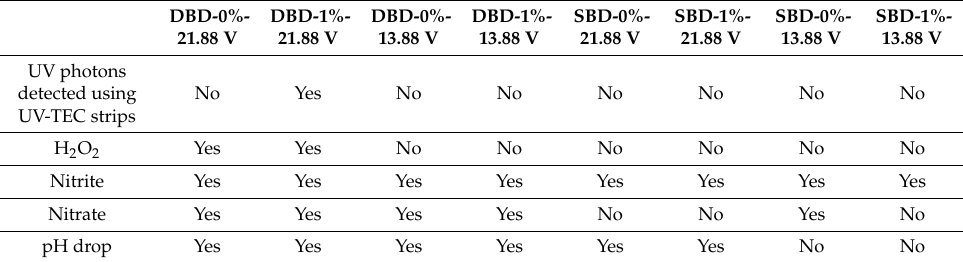
Table 2. Summary table indicating whether the di ff erent combinations of plasma characteristics resulted in the generation of UV photons, H 2 O 2 , nitrite, and nitrate, and / or a drop in